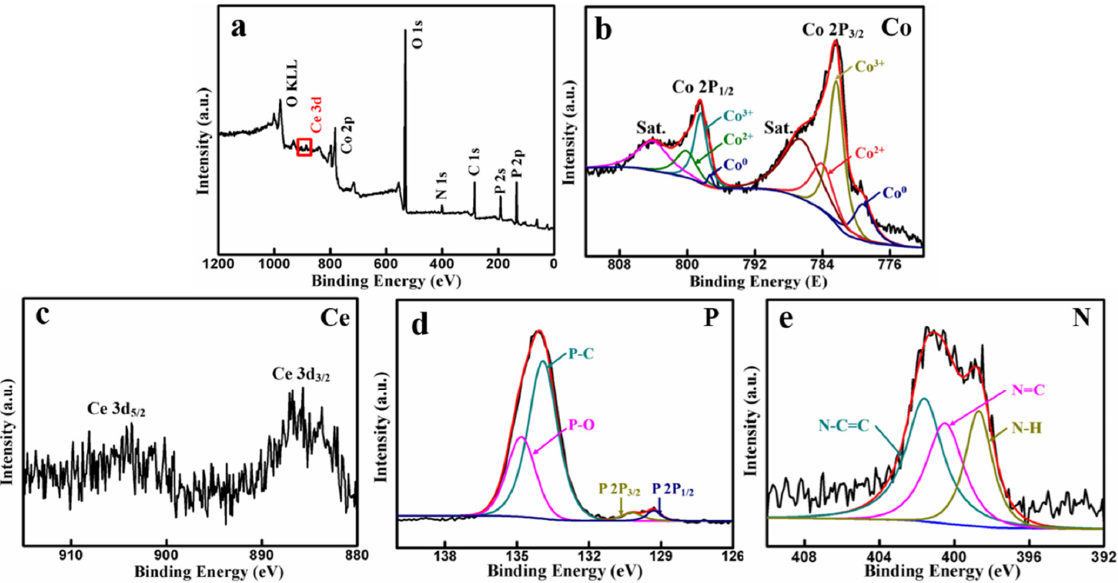
Figure 3. ( a ) XPS full spectrum, high-resolution XPS spectrum of ( b ) Co 2p, ( c ) Ce 3d, ( d ) P 2p, and ( e ) N 1s of Ce-doped CoP@NC.